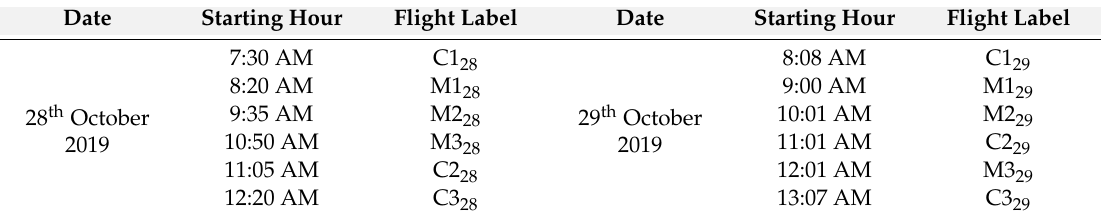
Starting Hour Flight Label